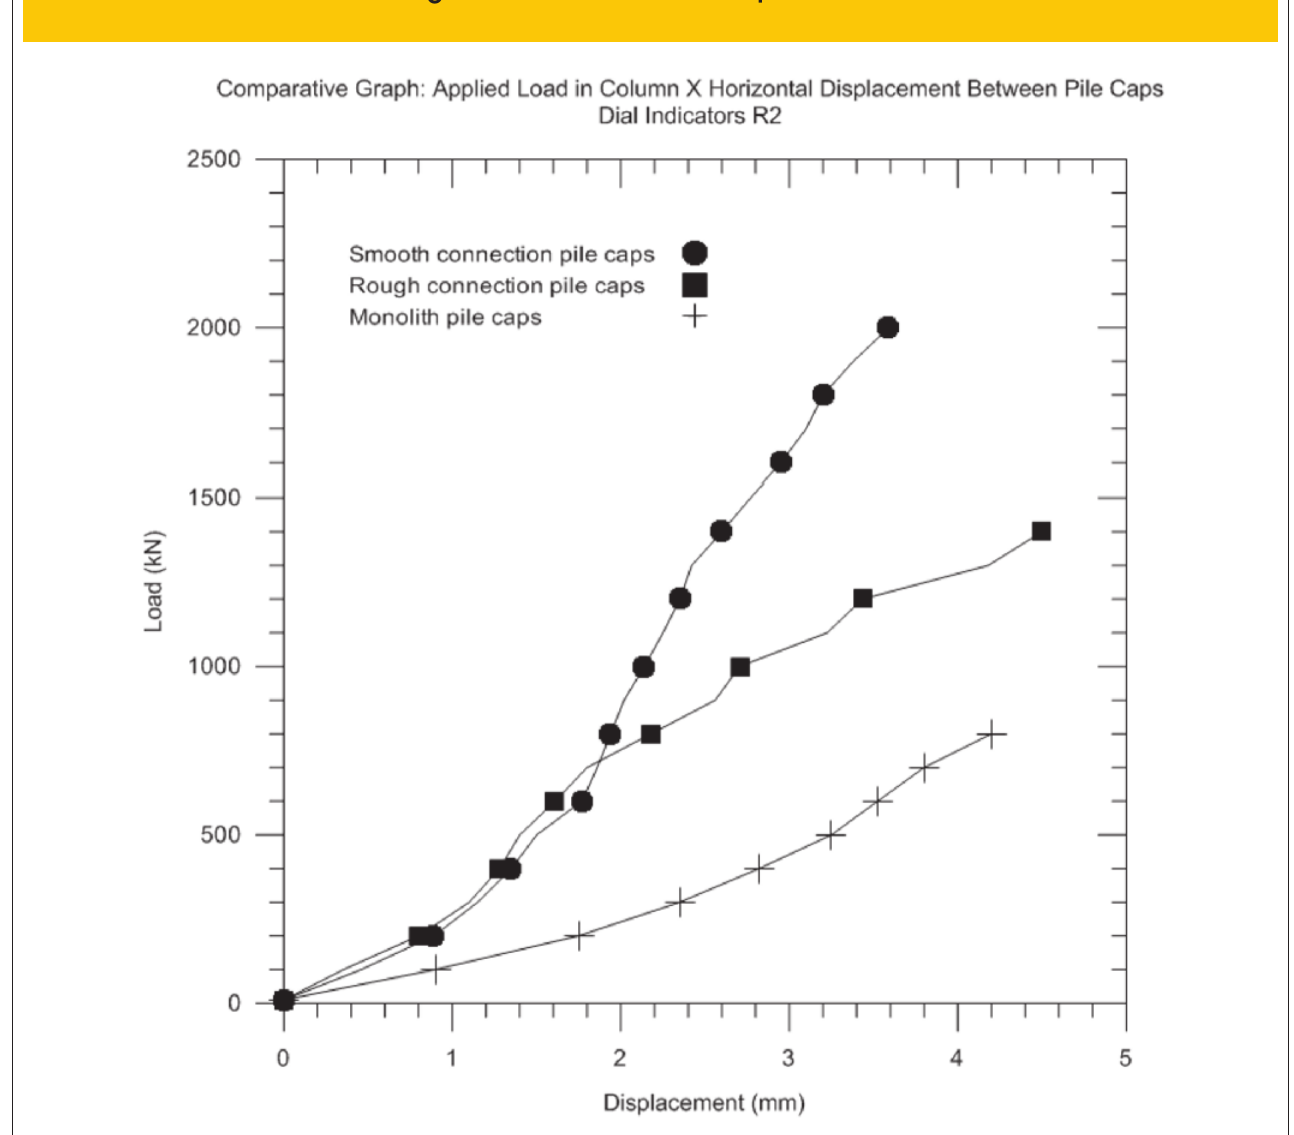
Figure 13 – Curve load vs.